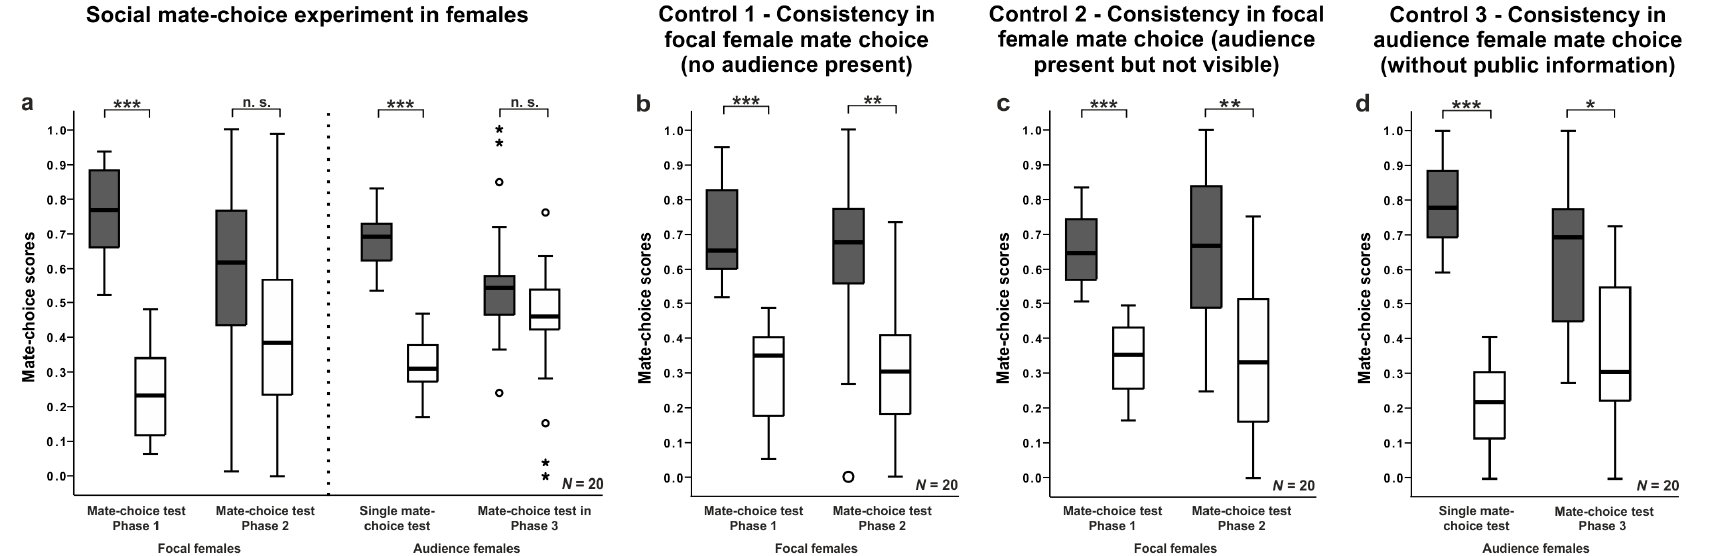
Figure 3. Female mate-choice experiment: Mate-choice scores of focal and audience females for preferred (grey boxplots) and non-preferred (white boxplots) stimulus males in single mate-choice experiments, social mate-choice experiments, and controls. Boxplots show median, quartiles and whiskers (1.5 x interquartile range). Circles indicate mild outliers, stars indicate extreme outliers. Significant p -values are from Wilcoxon matched-pairs tests (* p < 0.05; ** p < 0.01; *** p < 0.001; n.s. = non-significant).